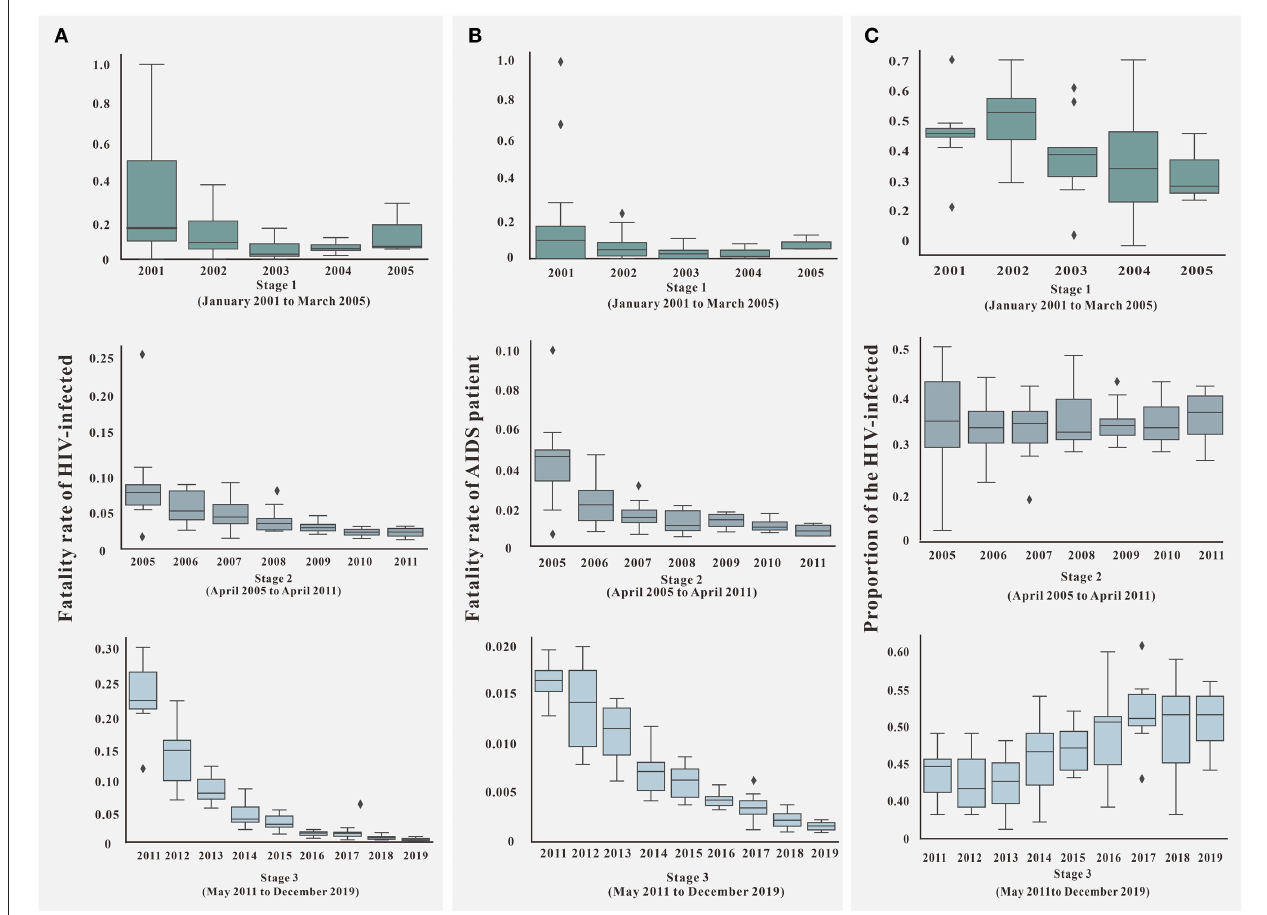
FIGURE 7 | Parameter of f 1 , f 2, and p in three stages. (A) The fatality rate of HIV-infected ( f 1 ) in different stages; (B) the fatality rate of AIDS patient ( f 2 ) in different stages; (C) the proportion of HIV-infected ( p ) in different stages.